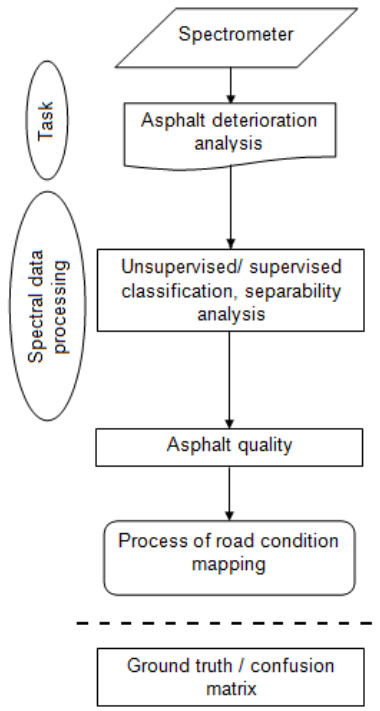
Figure 5. Workflow of the road deterioration mapping using